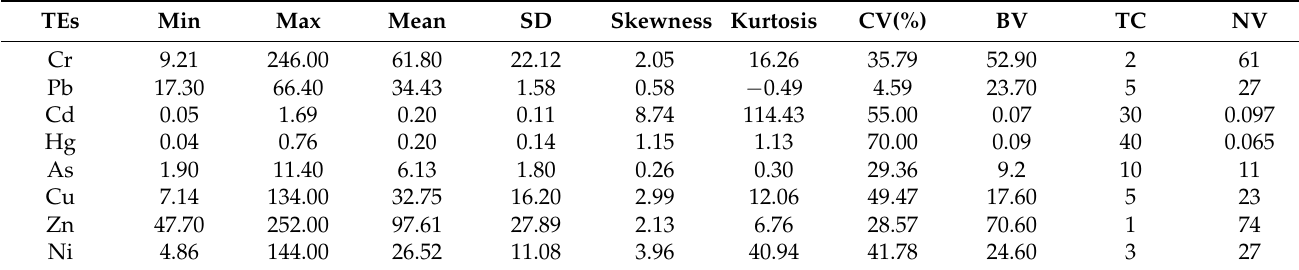
Table 1. Summary statistics of TEs in soil of Yuyao City (mg/kg) ( n =